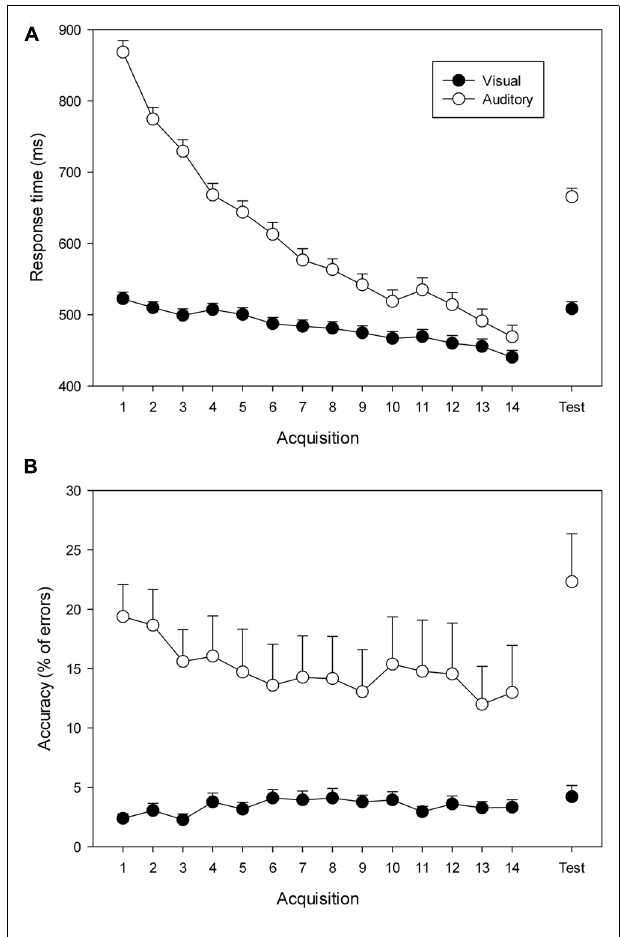
FIGURE 2 | Mean response times (A) and error rates (B) during practice (Blocks 1–14) and test (Test) for the visual (filled circles) and auditory (open circles) groups. Error bars reflect the standard errors of the